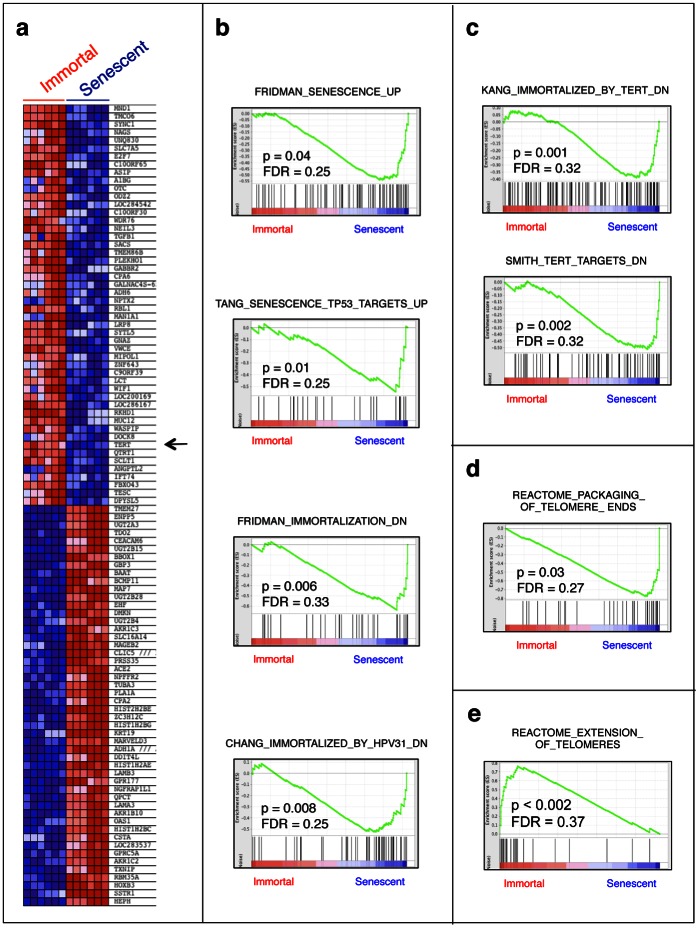
Gene expression profile analysis by gene set enrichment analysis assay (GSEA) established that senescent and immortal Huh7 clones displayed differential expression of previously identified senescence- and immortality-associated gene sets respectively, as well as those regulating telomere maintenance.(a) Heat map representation of the top 100 deregulated genes in immortal Huh7 clones (Immortal) versus senescent Huh7 (Senescent) clones. Red: up-regulated; blue: down-regulated; arrow indicates TERT gene whose expression is down-regulated in senescent clones. Previously identified gene sets (available at molecular signature database (MSigDB; www.broadinstitute.org/gsea/) were screened to identify those that are differentially enriched in senescent or immortal Huh7 clones by the analysis of their relative expression levels using GSEA method. (b) Gene set enrichment plots showing the up-regulated expression of two previously known senescence-associated gene sets in senescent Huh7 clones, including genes that are commonly up-regulated in senescent cells (“FRIDMAN_SENESCENCE_UP”) [10] and p53-responsive genes up-regulated during replicative senescence arrest (“TANG_SENESCENCE_TP53_TARGERTS_UP”) [41]. In addition, genes known to be down-regulated during immortalization in general (“FRIDMAN_IMMORTALIZATION_DN”) [10], and by human papillomavirus 31 (“CHANG_IMMORTALIZED_BY_HPV_DN”) [42] were also up-regulated in senescent Huh7 clones. (c) Genes known to be down-regulated by TERT-mediated immortalization (“KANG_IMMORTALIZED_BY_TERT_DN”) [43] and TERT-repressed target genes (“SMITH_TERT_TARGETS_DN”) [44] were also enriched in senescent Huh7 clones. (d) Genes involved in telomere end packaging (“REACTOME_PACKAGING_OF_TELOMERE_ENDS”; www.reactome.org) were upregulated in senescent Huh7 clones. (e) In contrast, genes involved in telomere extension (“REACTOME_EXTENSION_OF_TELOMERES”; www.reactome.org) were enriched in immortal Huh7 clones. Enrichment scores (ES) are shown on the y-axis. Positive and negative ES indicate enrichment in immortal and senescent Huh7 clones, respectively. X-axis bars represent individual genes of the indicated gene sets. FDR: False discovery rate, p: nominal p-value. Three biological replicates from each clone were analyzed for genome-wide gene expression using Affymetrix 54 K microarrays and normalized data were used for gene set enrichment analysis (GSEA).